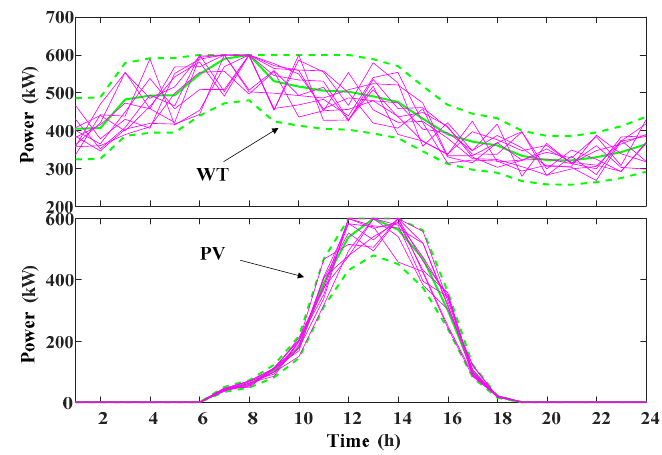
Figure 3. Output interval and scenarios of WT/PV .